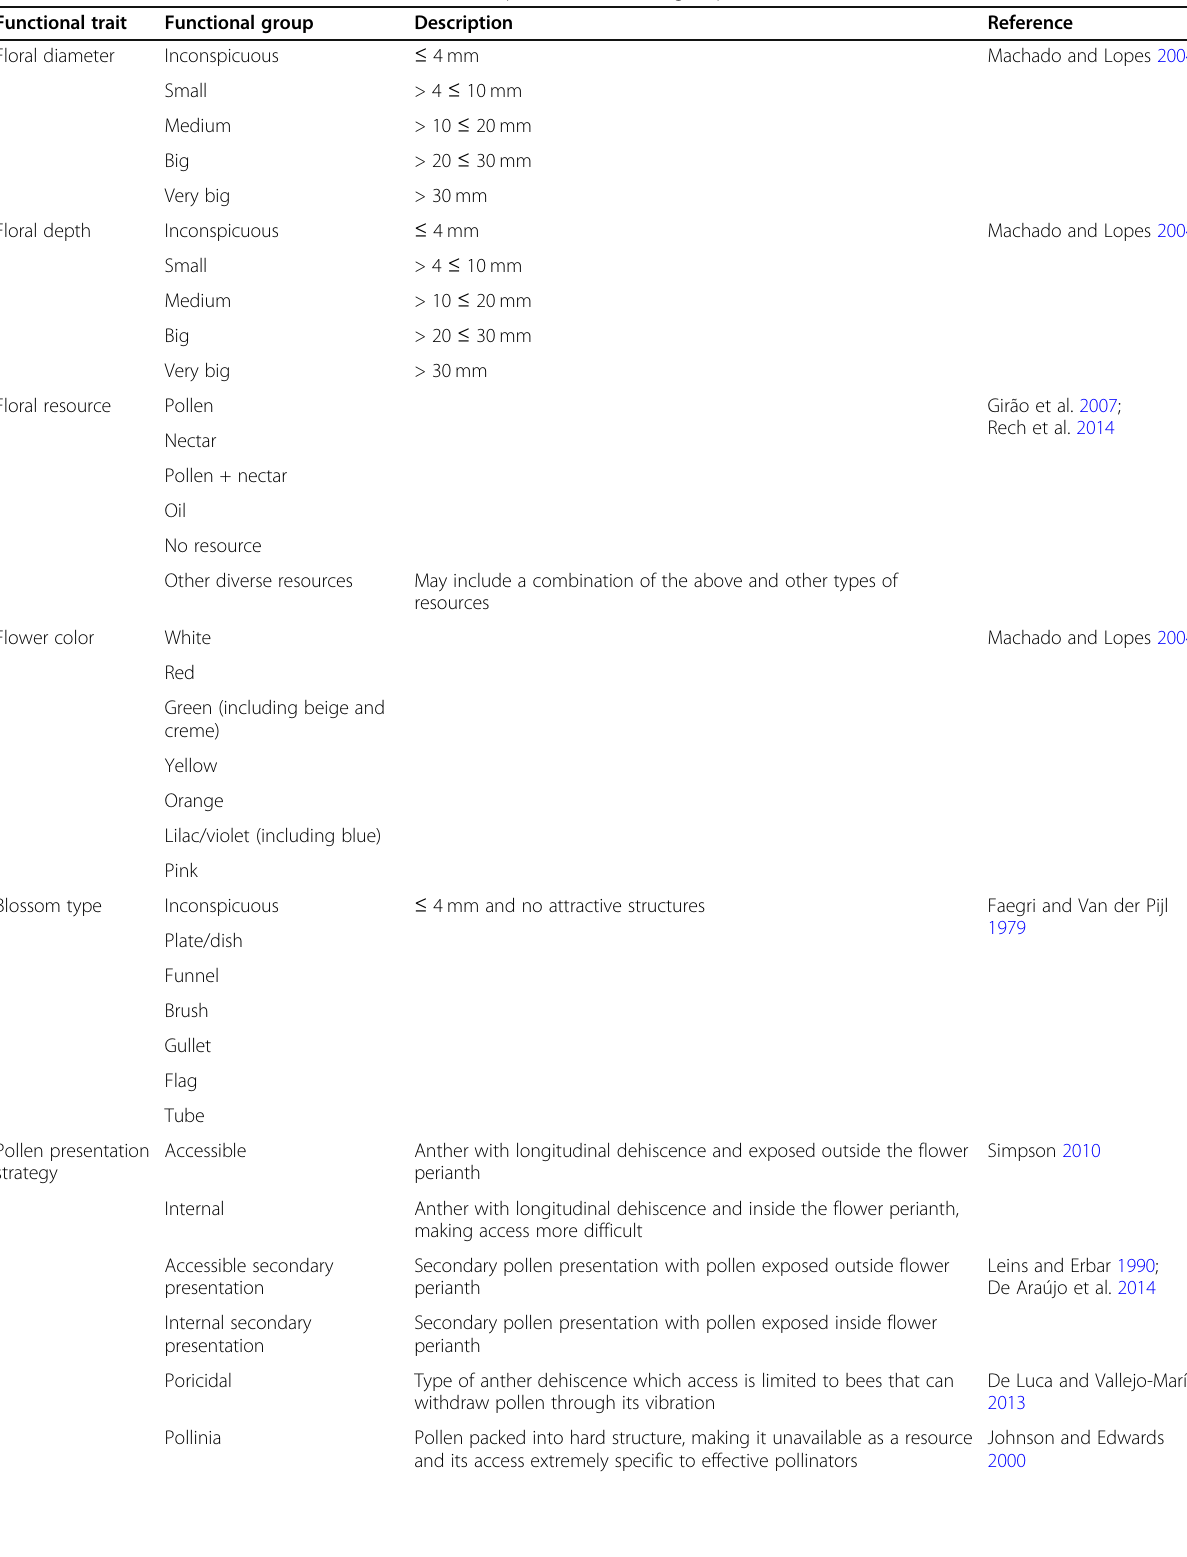
Table 2 Pollination-related functional traits and their respective functional